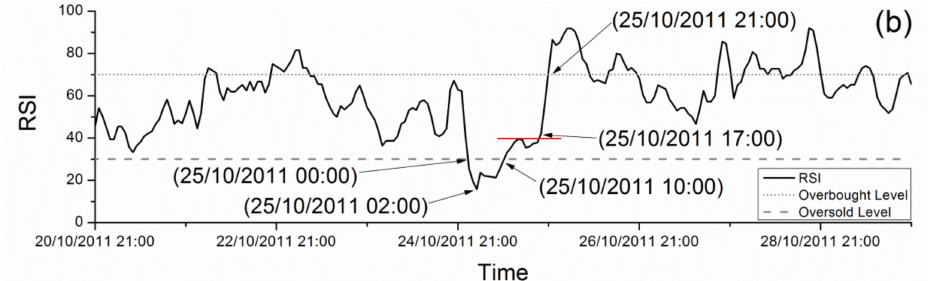
Figure 6. The evolution of an MS which occurred in 2011 in terms of ( a ) the SMA and Bollinger bands, and ( b ) the RSI indicator. The analyses results for a nine-day period from 20 October 2011 21:00 (UT) to 29/10/2011 21:00 (UT) are presented. The exact time and D st value for which specific features were found are marked on the figure using